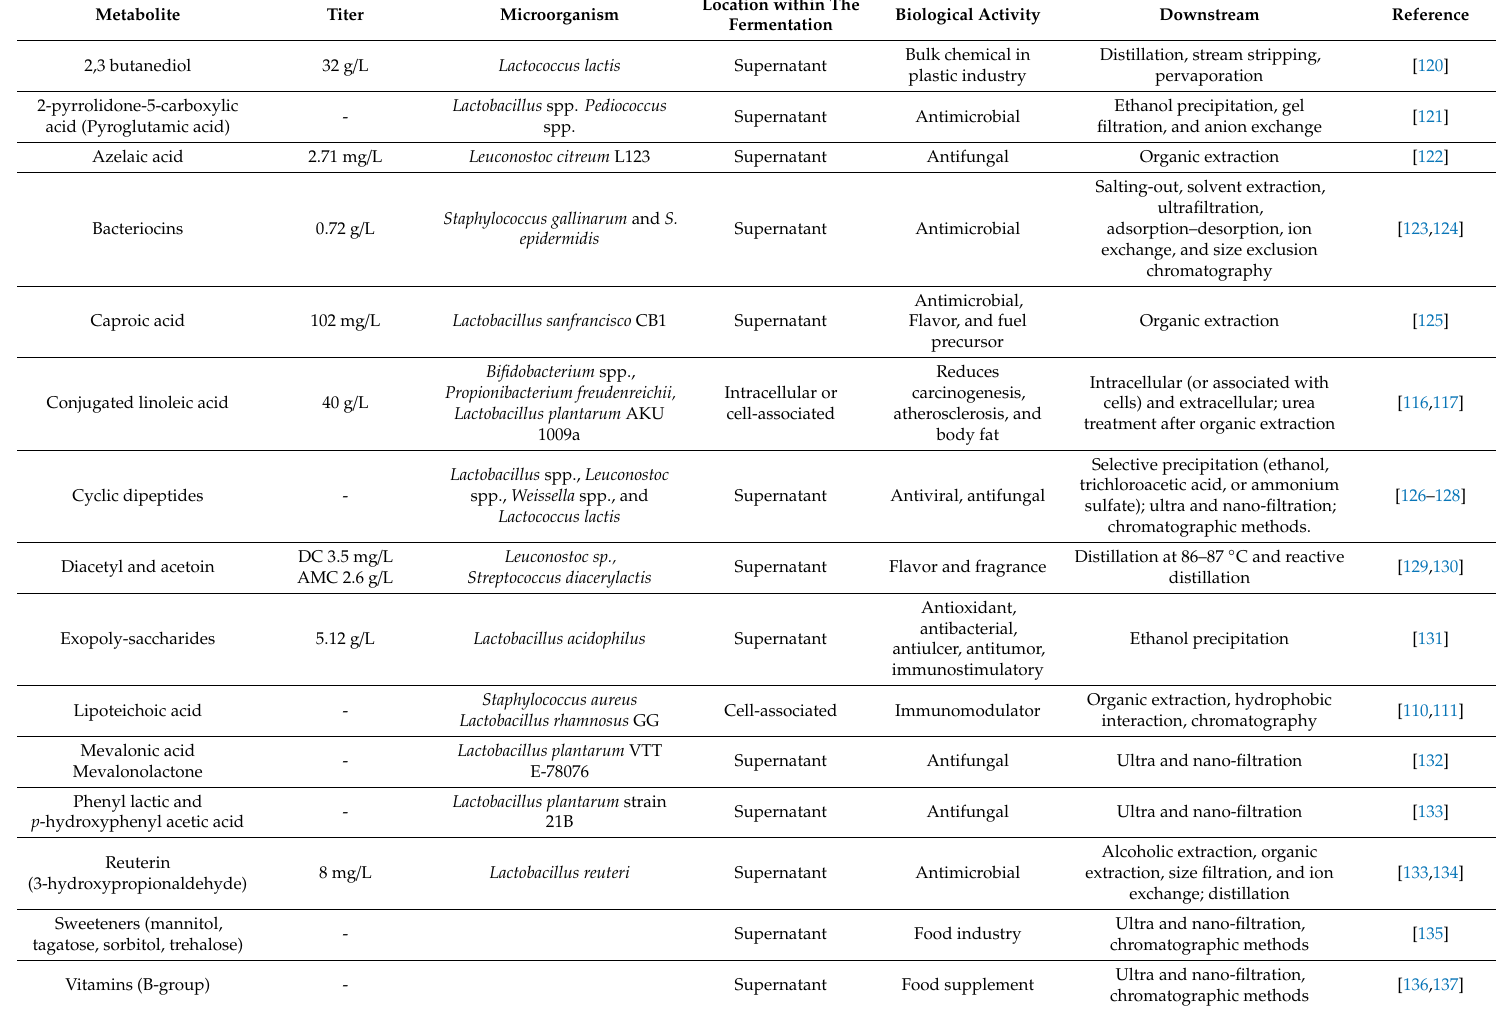
Table 2. Secondary metabolites produced by LAB compatible with a multi-product